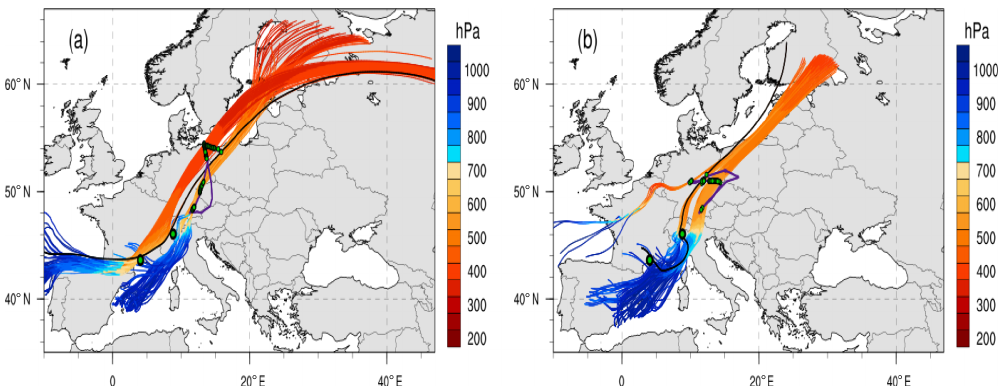
Figure 6. (a) Forward and backward trajectories from all EDA members started from the IOP2b flight route (purple line) which fulfil the WCB criterion (coloured with pressure, in hPa); locations where the WCB trajectories were observed are shown by green markers (see text for details). (b) Same for IOP2c. Trajectories are shown for the time interval 12:00UTC on 13 October to 06:00UTC on 16 October. In each panel, the black trajectory marks the one discussed in detail in Fig.